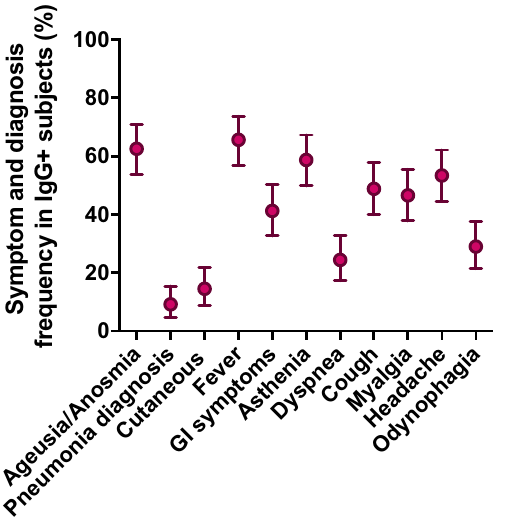
Figure 3. Symptom distribution among IgG positive subjects. Dots and vertical lines represent the mean and 95% confidence interval, respectively. GI,